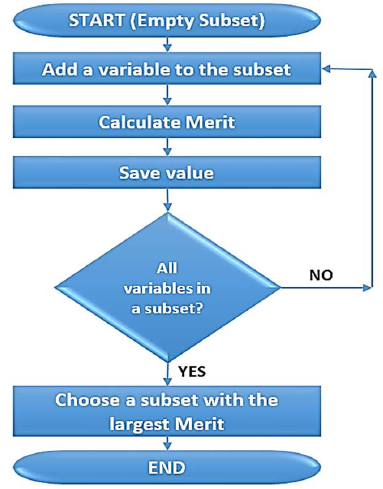
Figure 3. Forward selection search algorithm